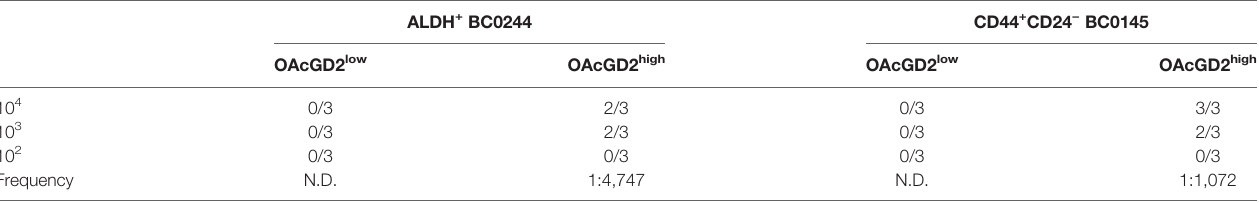
TABLE 2 | Generation of tumors by OAcGD2 low and OAcGD2 high breast cancer cells in vivo .